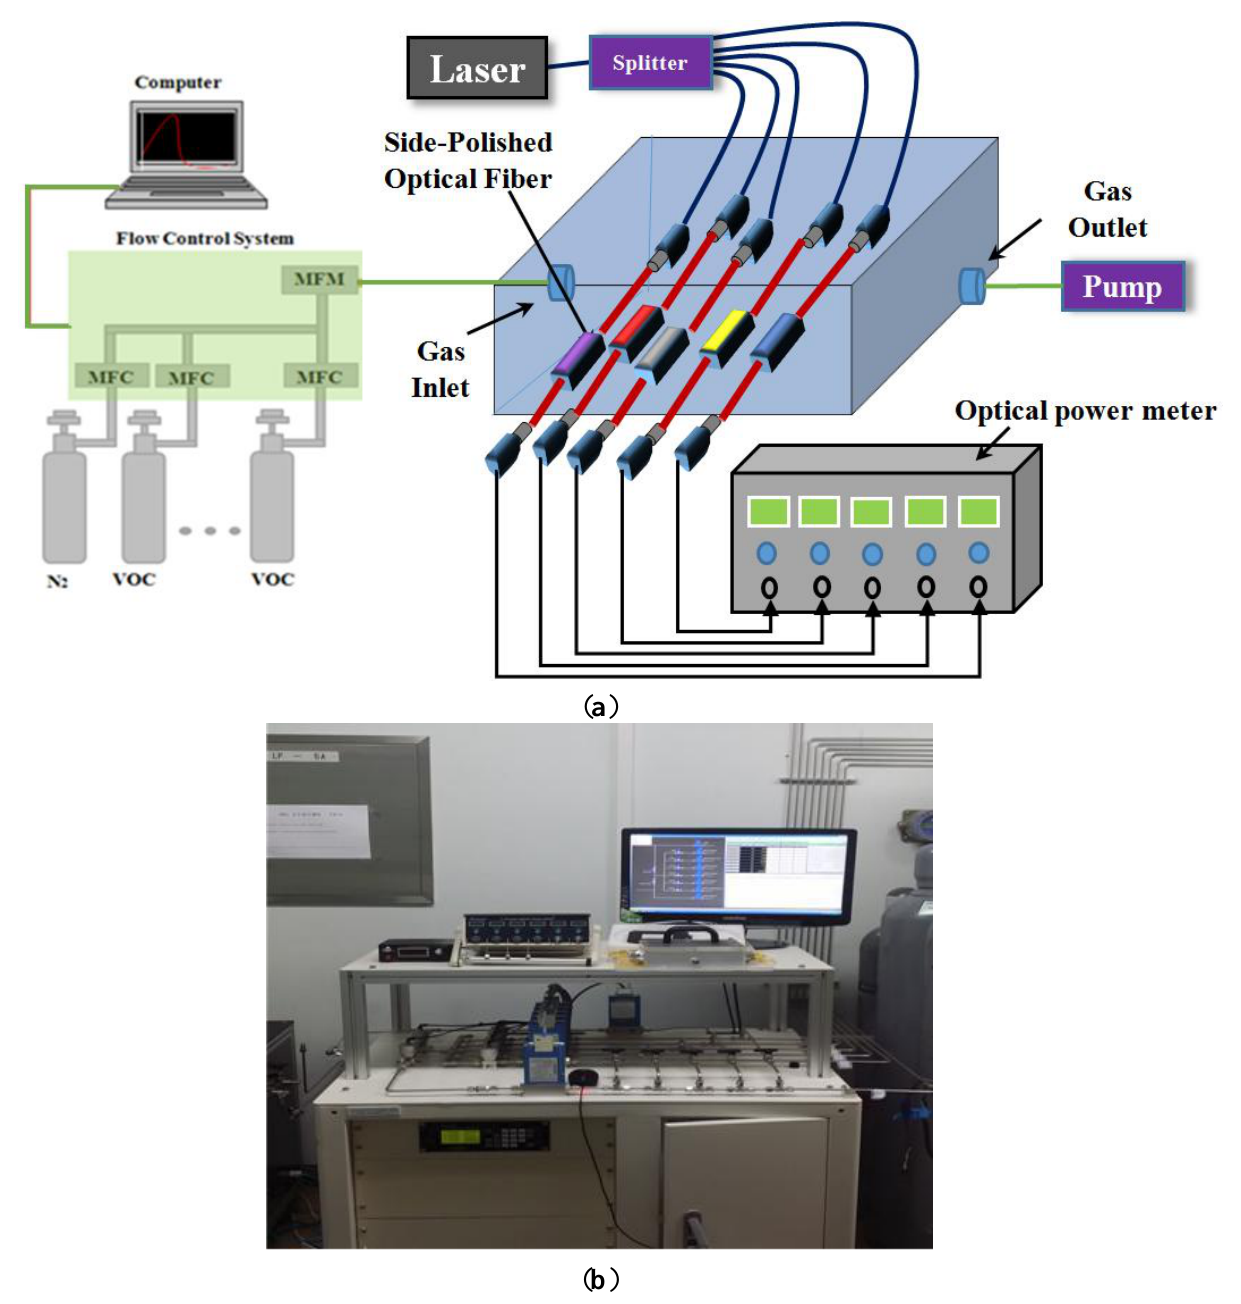
Figure 5. ( a ) The schematic diagram and ( b ) photograph of the multi-array VOCs gas detection